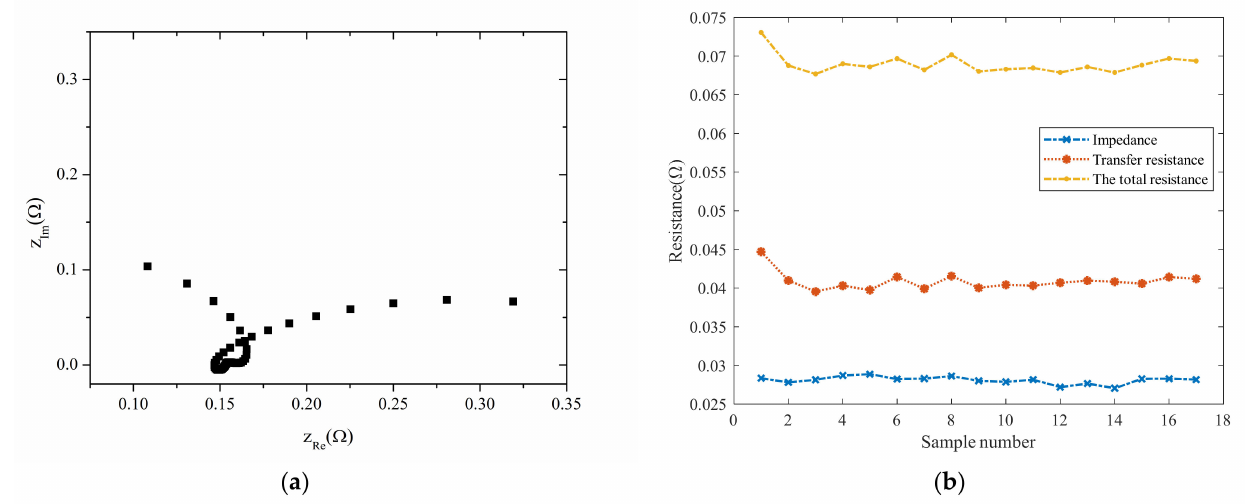
Figure 3. Internal resistance: ( a ) impedance Nyquist diagram; ( b )